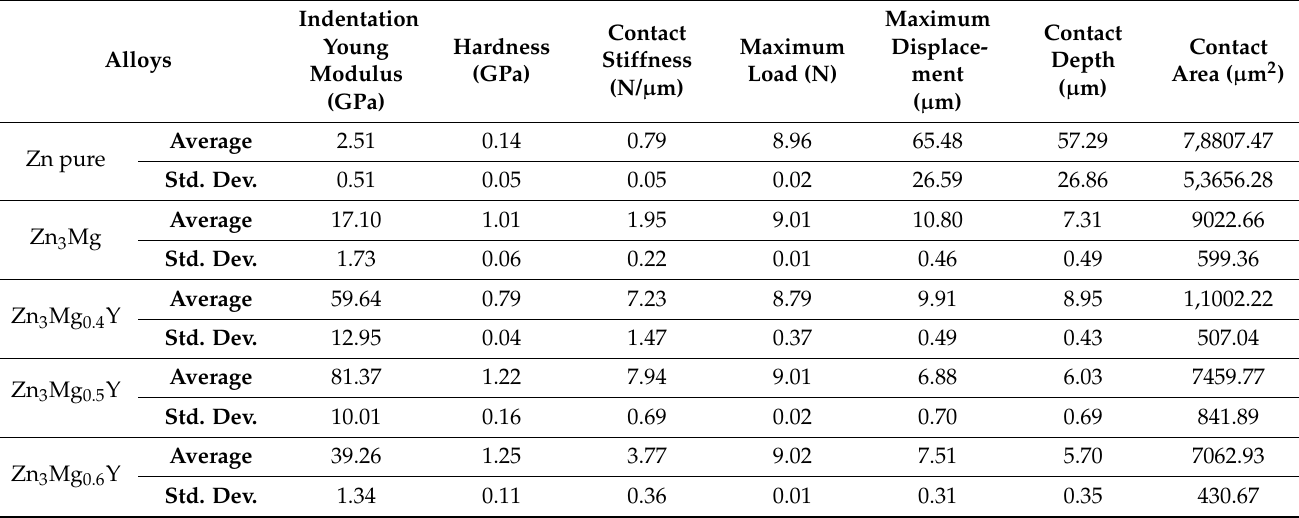
Table 6. Microhardness experiment values for